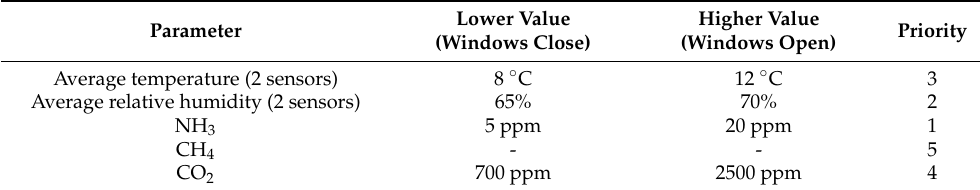
Table 2. Parameters range for opening and closing of windows.